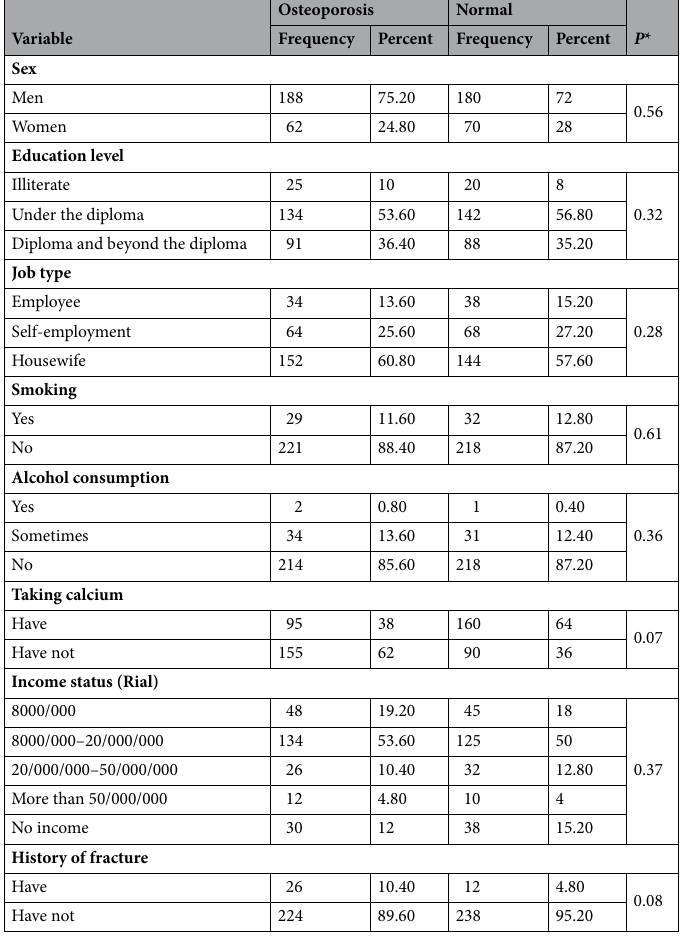
Table 1. Demographic characteristics of osteoporosis and normal groups. *Chi-square test.